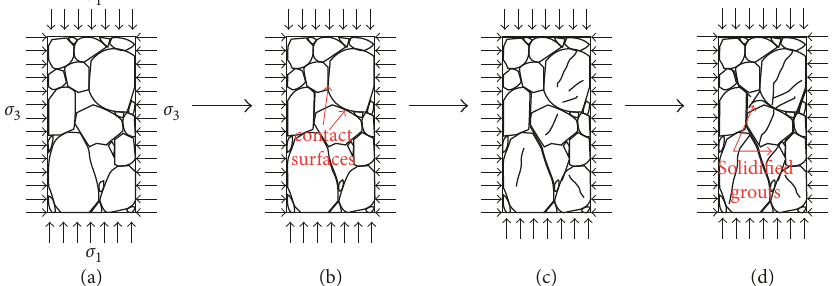
Figure 10: Microscopic cracks evolution process in the grouted crushed coal specimen with the confining pressure being constant and the axial pressure increasing